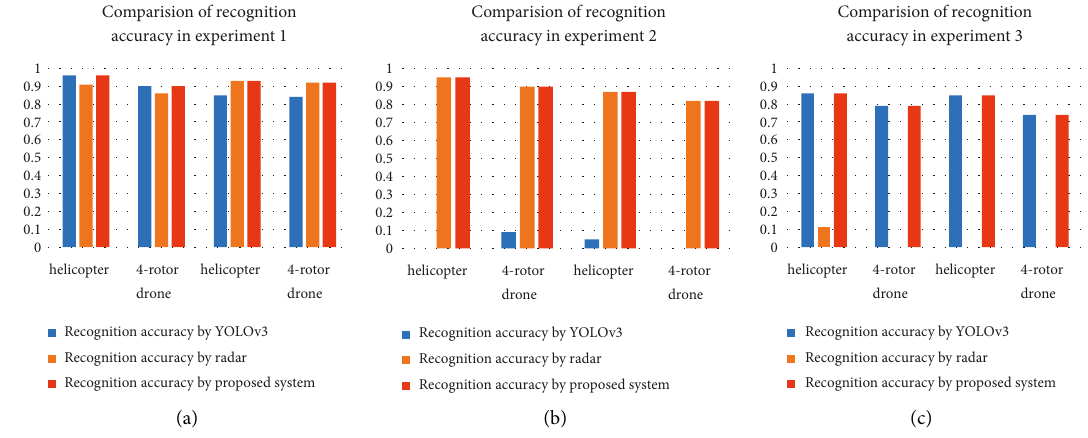
Figure 11: Comparison of recognition accuracy in 3 experiments. (a) Experiment 1. (b) Experiment 2. (c) Experiment